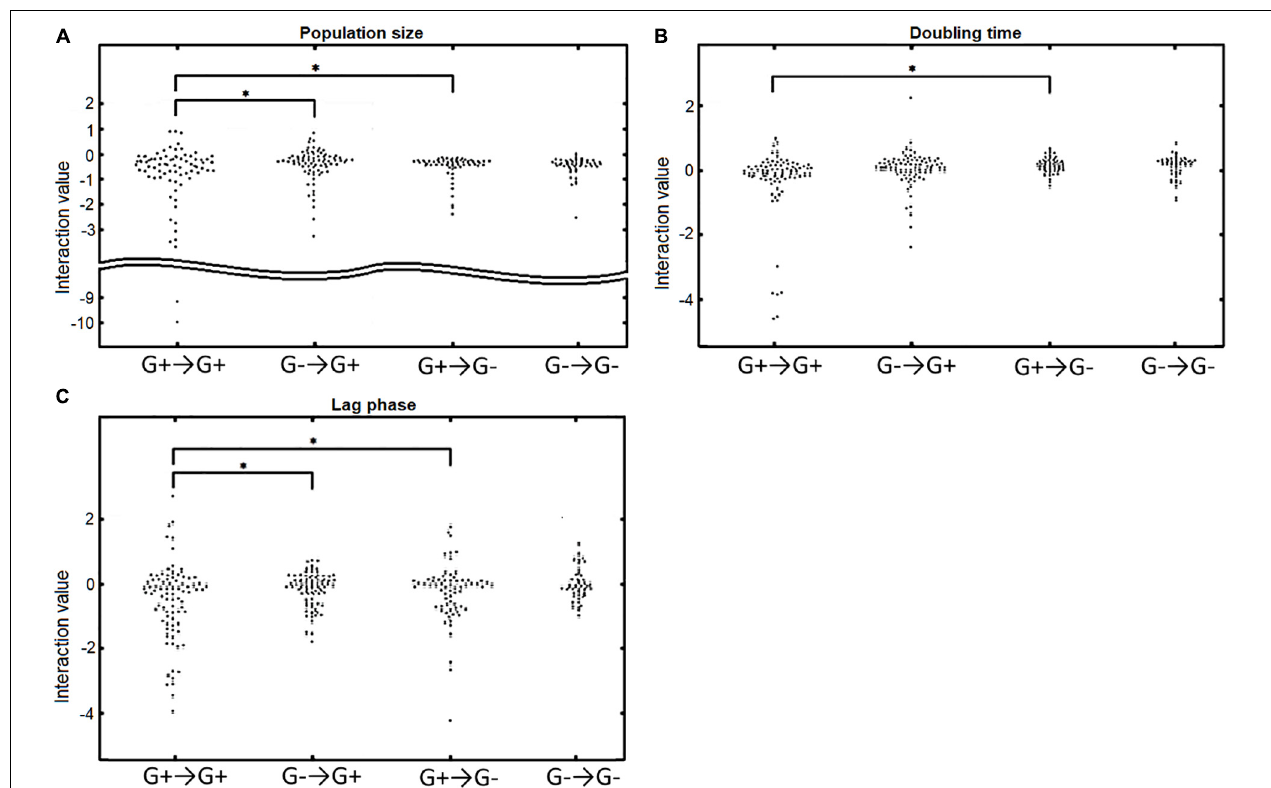
FIGURE 4 | The response of Gram-positive (G+) and Gram-negative (G–) acceptors to Gram-positive or Gram-negative donors. G+ → G+ indicates the response of Gram-positive acceptors to Gram-positive donors, G– → G+ indicates the response of Gram-positive acceptors to Gram-negative donors, G+ → G– indicates the response of Gram-negative acceptors to Gram-positive donors, and G– → G– indicates the response of Gram-negative acceptors to Gram-negative donors. (A) Population size interactions.Gram-positive acceptors responded significantly different to Gram-positive and Gram-negative donors ( p = 0.031). In contrast, Gram-negative acceptors did not respond differently to Gram-positive or Gram-negative donors ( p = 0.70). Gram-positive and Gram-negative acceptors responded significantly different to Gram-positive ( p = 0.022), but not to Gram-negative donors ( p = 0.63). (B) The effect of interactions on doubling time. There was a significant difference for Gram-positive and Gram-negative acceptors responding to Gram-positive donors ( p = 0.023), but not to Gram-negative donors ( p = 0.90). No significant difference was observed for Gram-negative acceptors responding to either Gram-positive donors or Gram-negative donors ( p = 0.076). Neither was there a difference in doubling time of Gram-positive acceptors responding to Gram-positive or Gram-negative donors ( p = 0.30). (C) Effect of interactions on the acceptors’ length of the lag phase. Gram-positive acceptors respond significantly different to Gram-positive and Gram-negative donors ( p = 0.0031). Such a difference was not observed for Gram-negative acceptors ( p = 0.093). Gram-positive and Gram-negative acceptors also responded significantly different to Gram-positive donors ( p = 0.024). Significance of results was calculated using Welch’s unequal variances t -test.